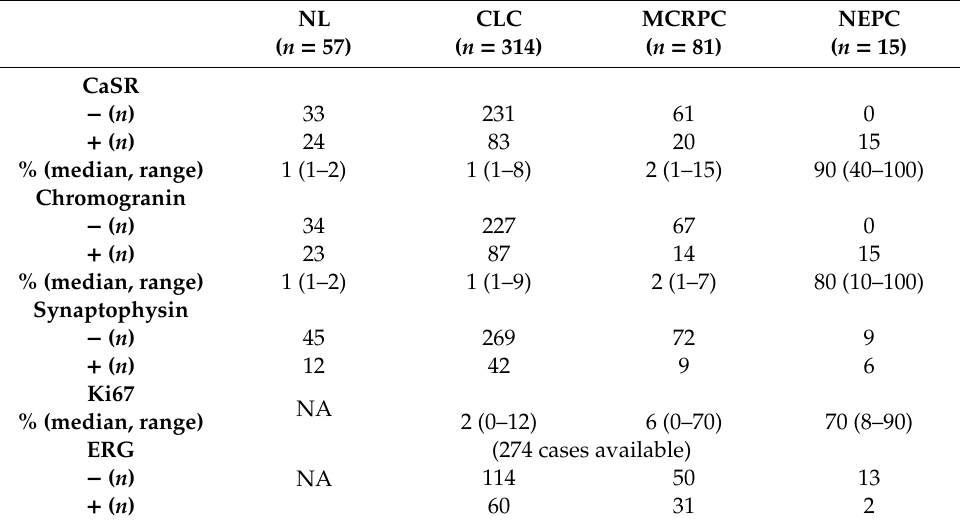
Table 1. Markers expression in prostate tissue samples.